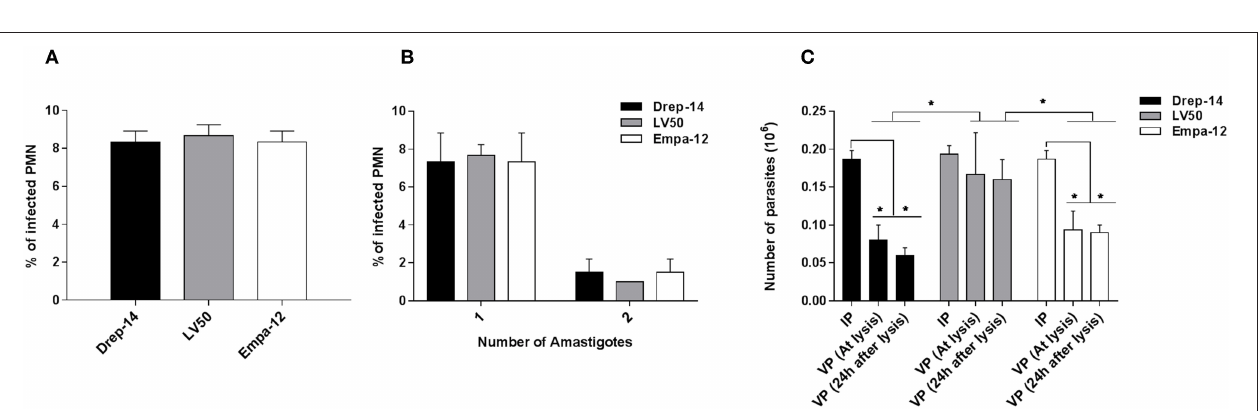
FIGURE 7 | Principal component analysis results. The PCA was performed using data from ten donors for eleven observations (infection index, percentage of infection, Oxidative burst, Elastase, MPO, IL-12p70, IL-8, IL-6, IL-10, IL1- β , and TNF- α ) under four conditions (NI = Non-Infected, and three infected conditions with the Drep-14, LV50 or Empa-12 strains). (A) The individuals’ map shows the distribution of the population projected on the 2D plane composed of the first two principal components PC1 and PC2 (Dim1 and Dim2, respectively). (B) The variable factors map shows the projection on the first two principal components (PC1 and PC2) of the different observations.